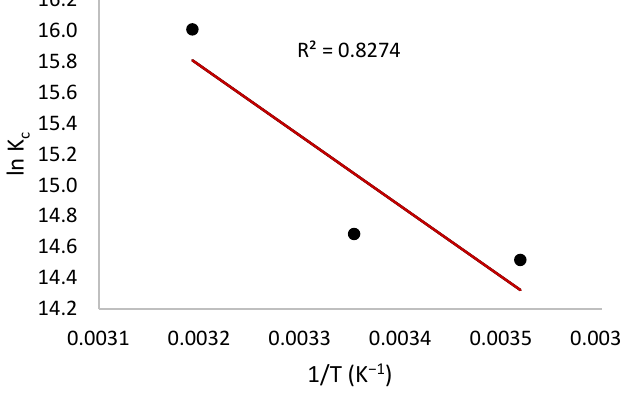
Figure 8. Plot of ln Kc versus 1/ T of the adsorption process. Table 5. The thermodynamic parameters of adsorption of MV onto HNC. The positive value of Δ H 0 (+37.84 kJ/mol) indicated that the adsorption process was Temperature